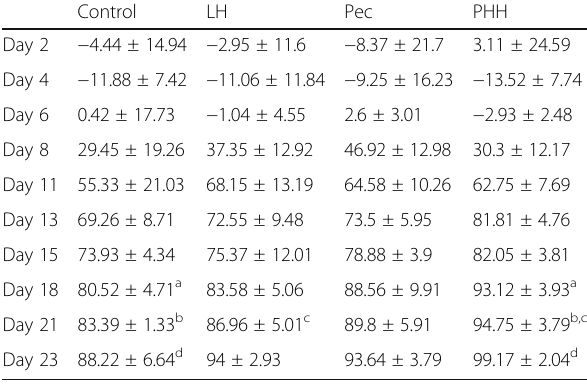
Table 1 Wound area reduction rate at each time point (±SD)